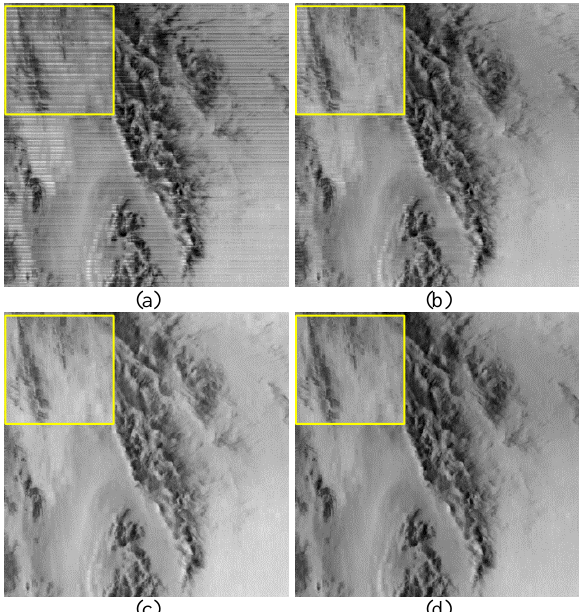
Fig 2. Destriping results of HYDICE band 103: (a) MM;